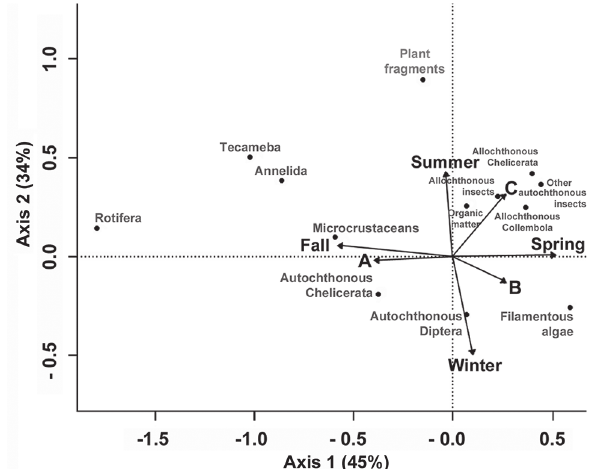
Fig. 4. Canonical Correspondence Analysis (CCA) of food composition of Atlantirivulus riograndensis representing the importance of seasonal and ontogenetic variables, with p <0:05, according to the length of arrows associated with each vector. Individuals collected at the Banado dos Pachecos wildlife refuge, Viamão, Rio Grande do Sul, Brazil, in 2012. A: ≤ 21.6 mm Standard length; B: Standard length from 21.7 to 32.6 mm; C: Standard length ≥ 32.7 mm.